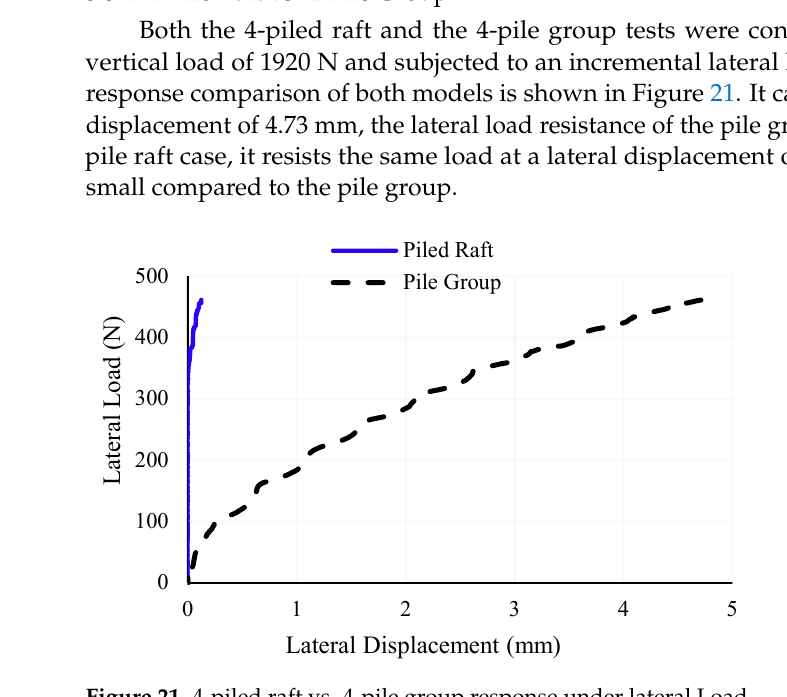
Figure 21. 4-piled raft vs. 4-pile group response under lateral Load.